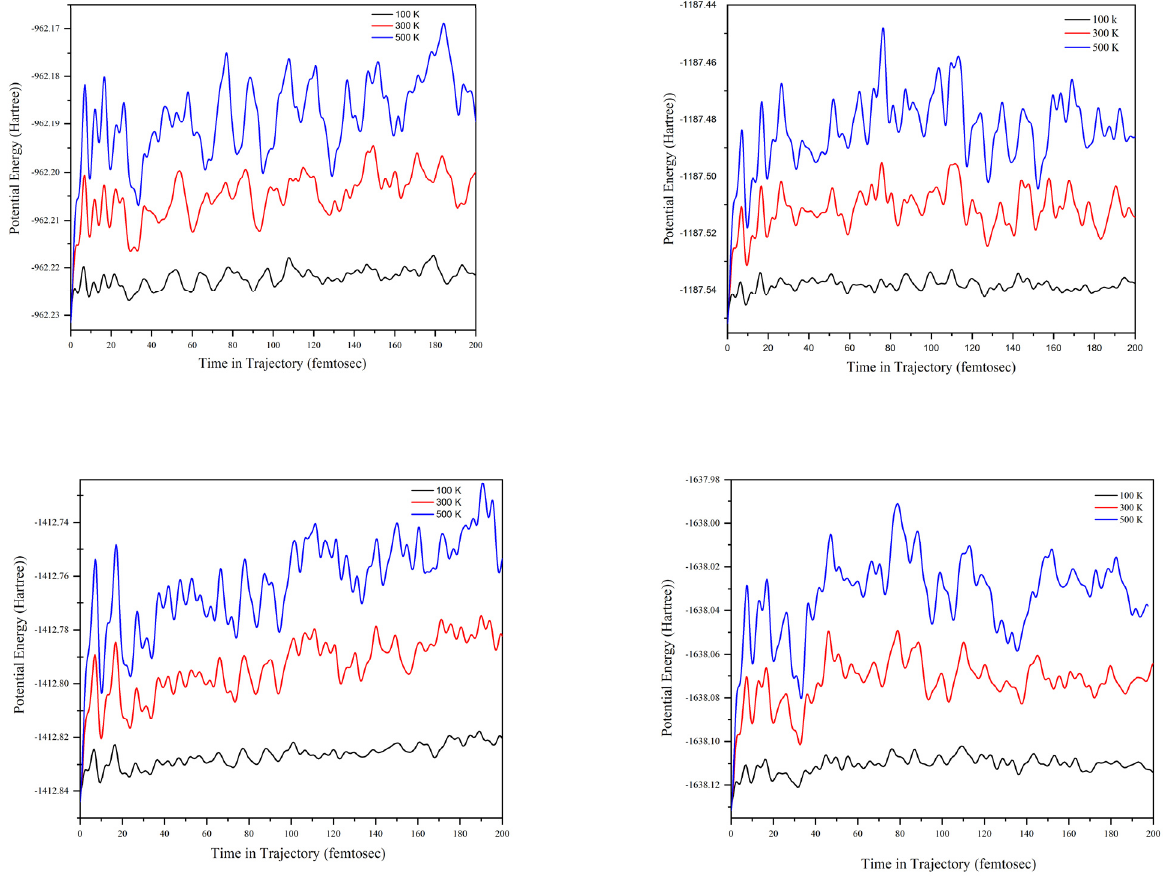
Figure 13. Relative potential energy trajectory curves for the ammonium sulfamate–urea system at different urea contents and different temperatures.